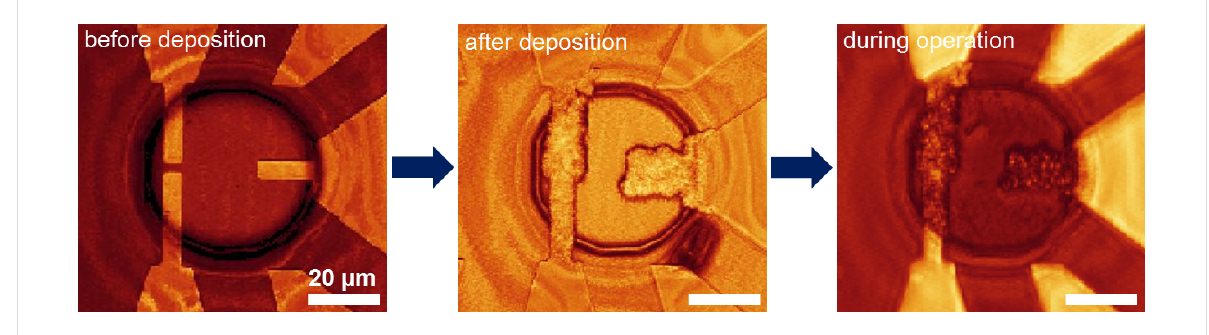
Figure 4: Observation of fabrication and operation of the copper atomic-scale transistor. Confocal microscopy images taken before electrochemical copper deposition, after deposition, and during transistor operation are shown (from left to right).